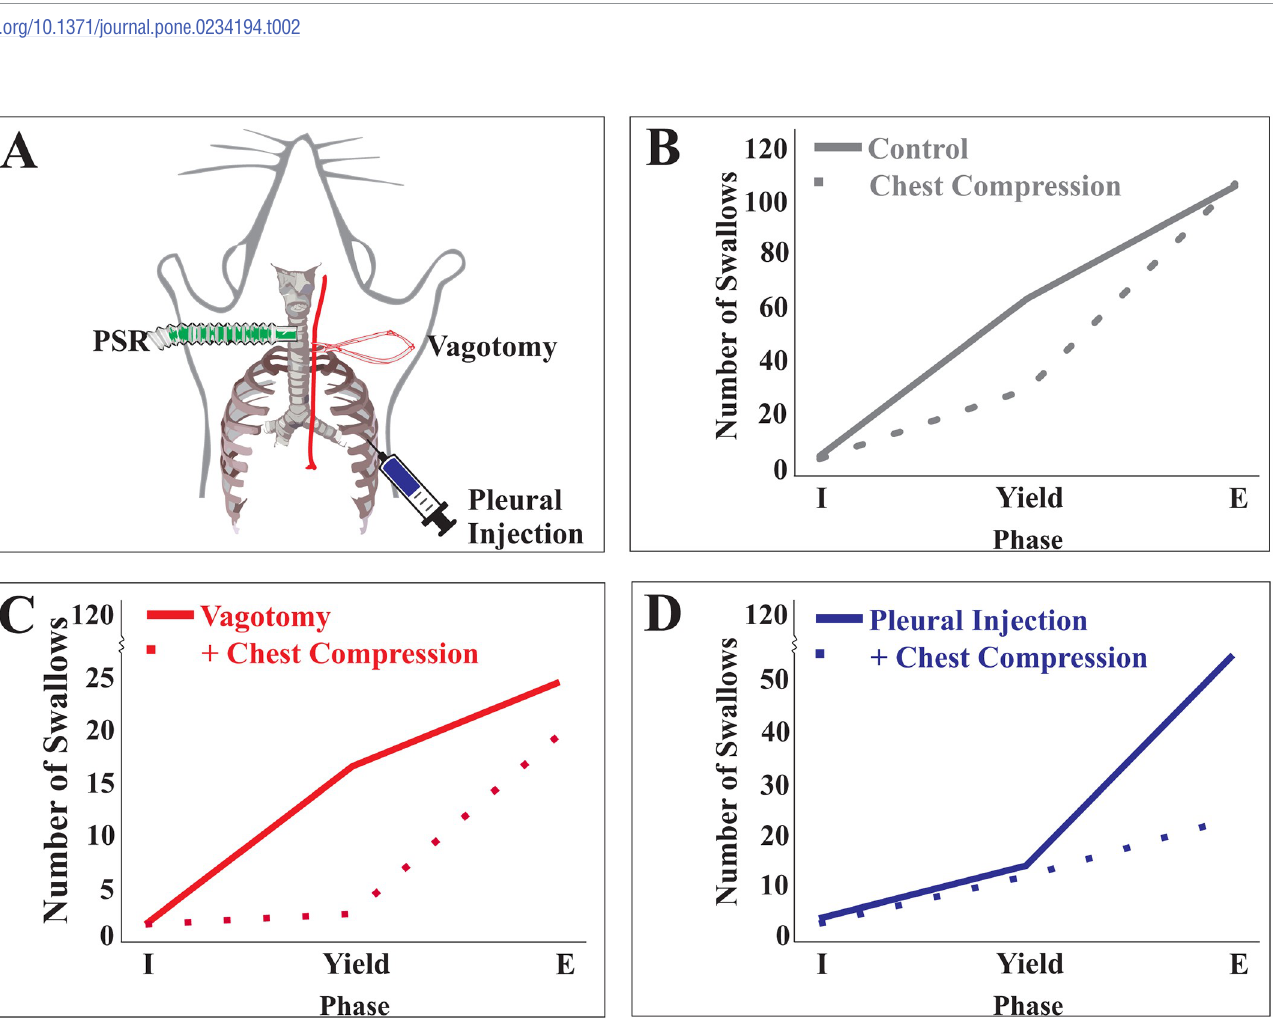
Reported p -values are from Wilcoxon signed ranks test. Significance is bolded at p -values � 0.05 and p -values indicating trends towards significant of 0.05 < x � 0.07 are italicized .